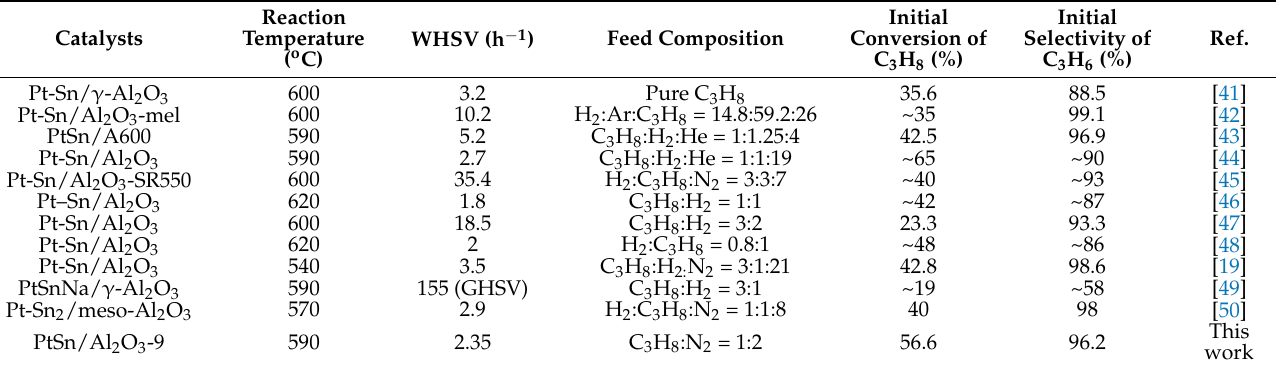
Table 3. Catalytic data of PtSn/Al 2 O 3 catalysts used in PDH